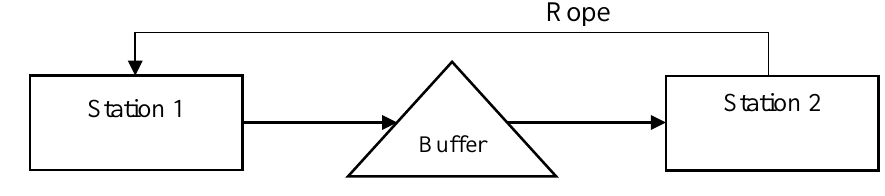
Fig. 3. A job shop production system with DBR